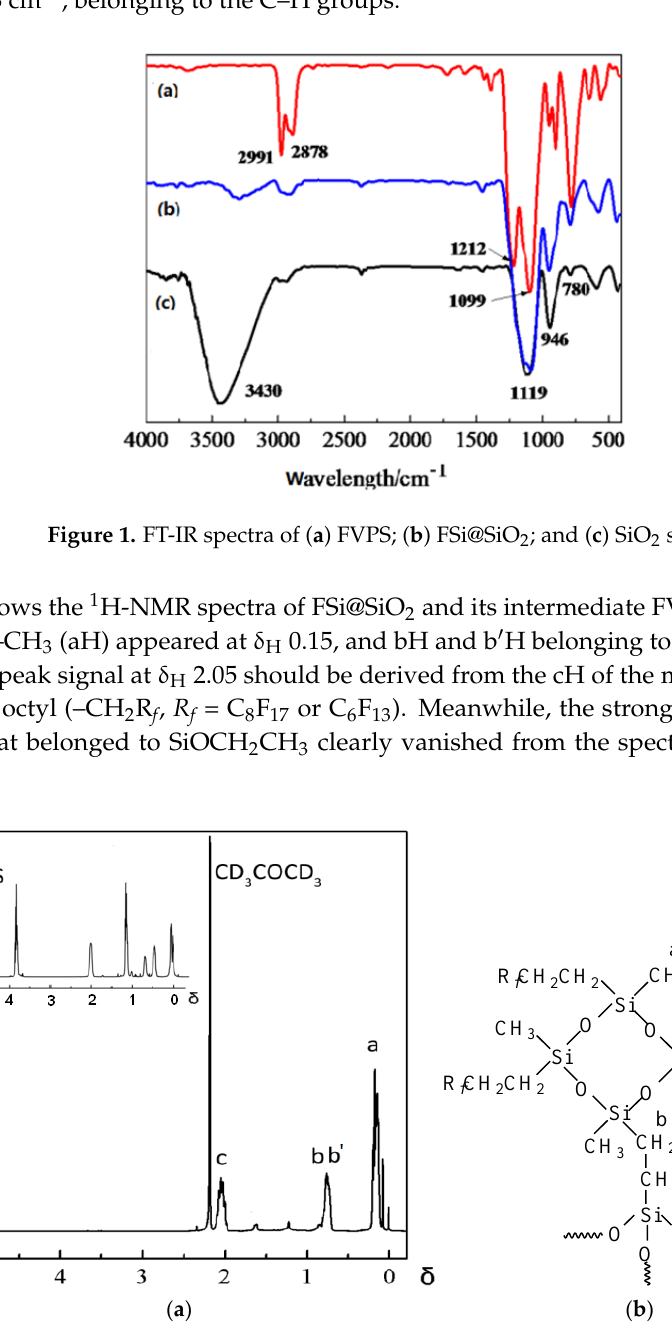
Figure 2. 1 H-NMR spectra of FSi@SiO 2 ( a ) and intermediate FVPS ( b ).